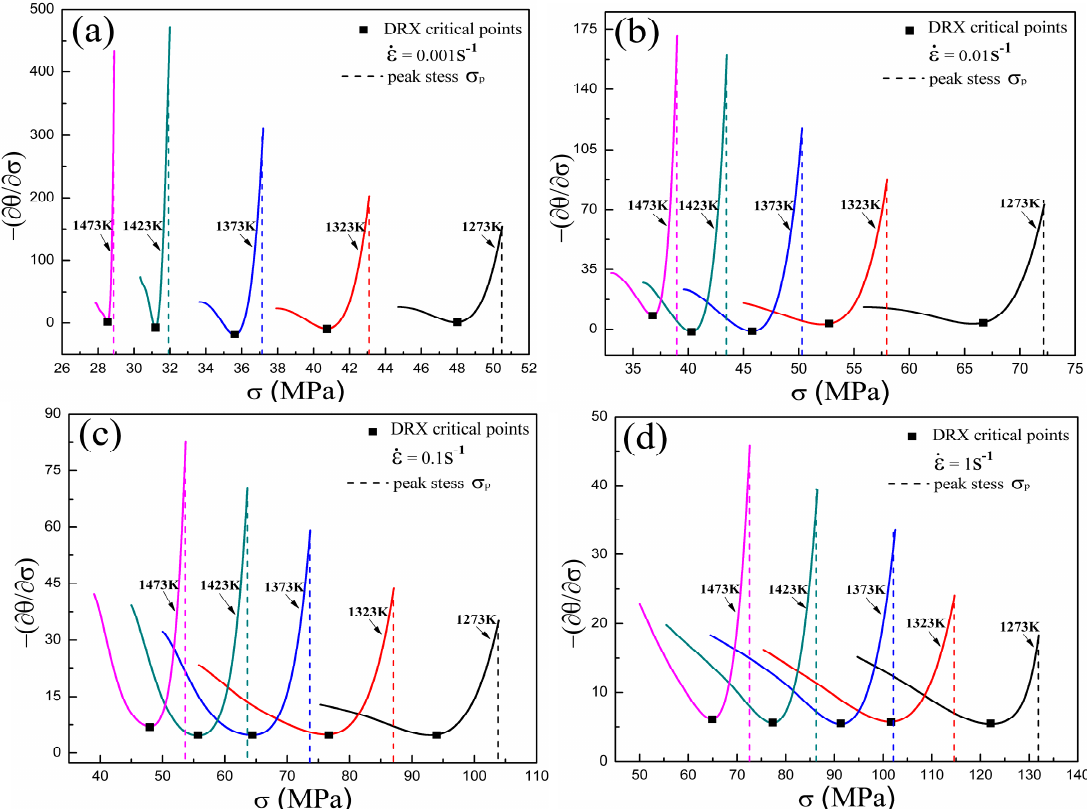
. . . ε = 0.001 s − 1 ; ( b ) ε = 0.01 s − 1 ; ( c ) ε = 0.1 s − 1 ; ε  ε  = 0.001 s -1 ; ( b ) = 0.01 s -1 ; ( c )